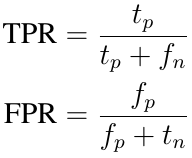
Figure 7. Simulation results: ( a ) Input ( b ) Ground truth ( c ) MoG ( d ) Method: Li et al.